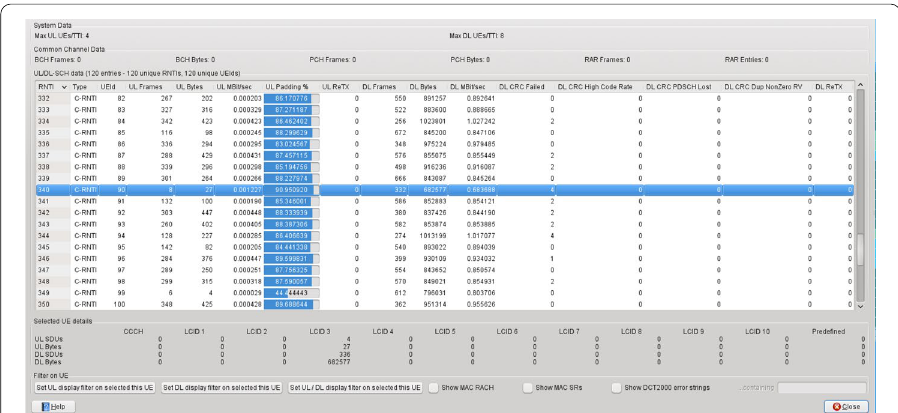
Fig. 10 Protocol analyzer MAC-LTE statistics screenshot